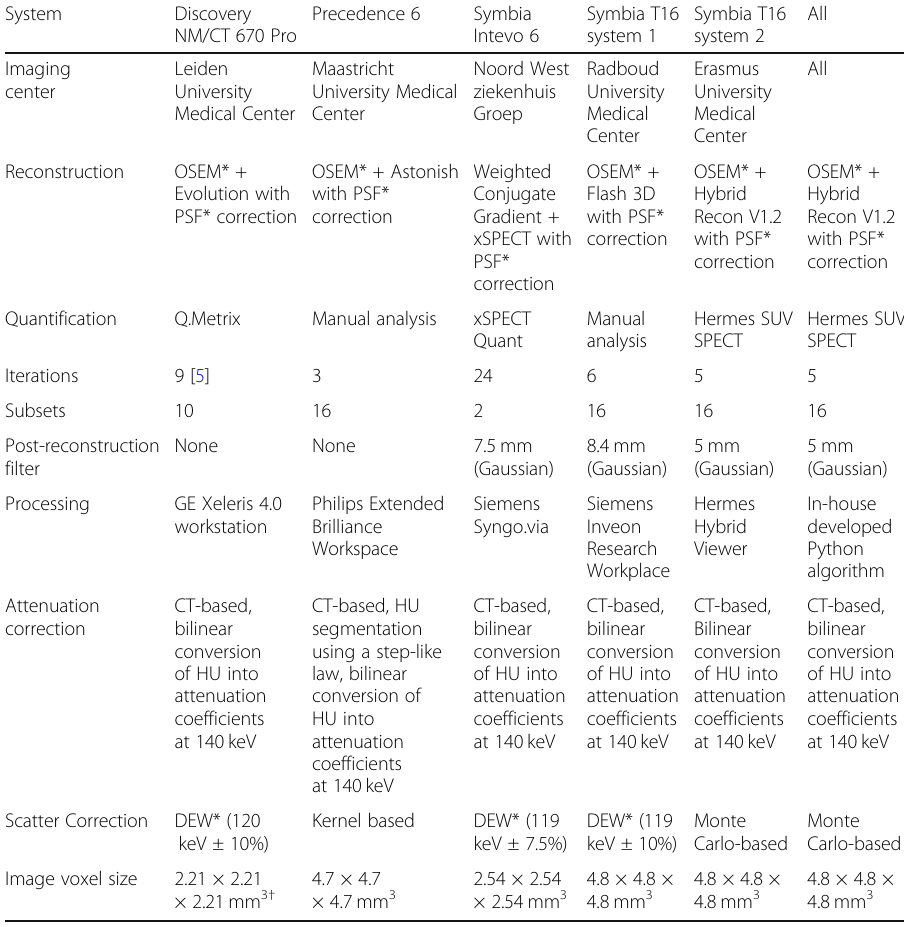
Table 3 Reconstruction and quantification parameters and processing software used in this study System